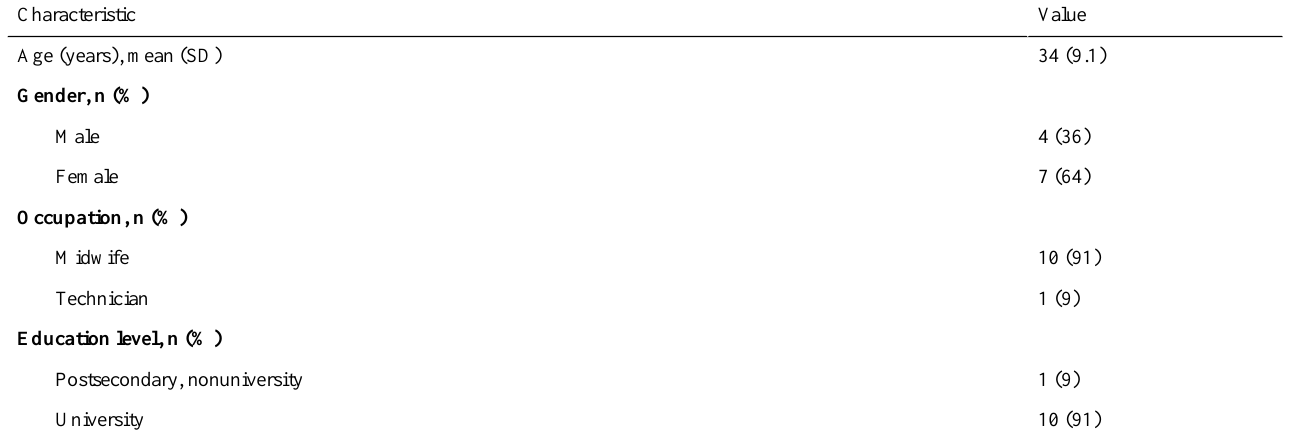
Table 2. Demographics of health professionals